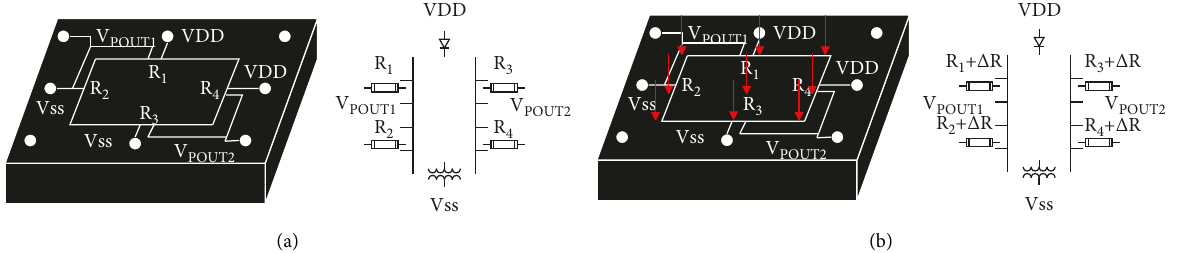
Figure 2: Schematic diagram of the working principle of the pressure sensor: (a) P